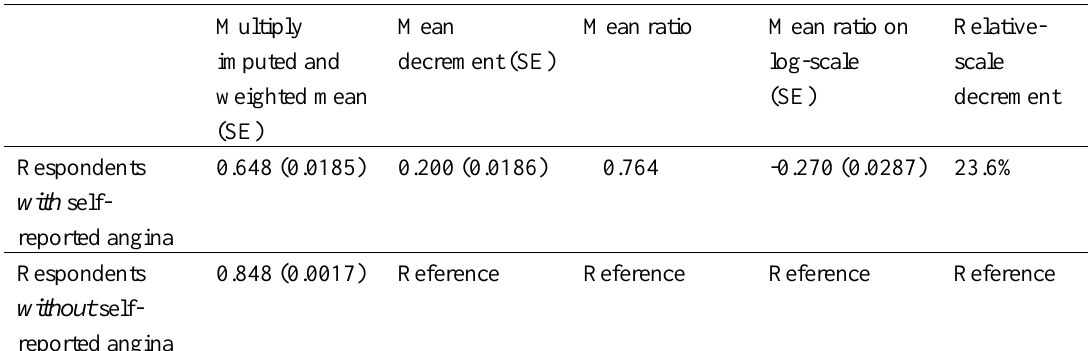
Estimated mean absolute-scale and mean relative-scale decrements for angina. An example